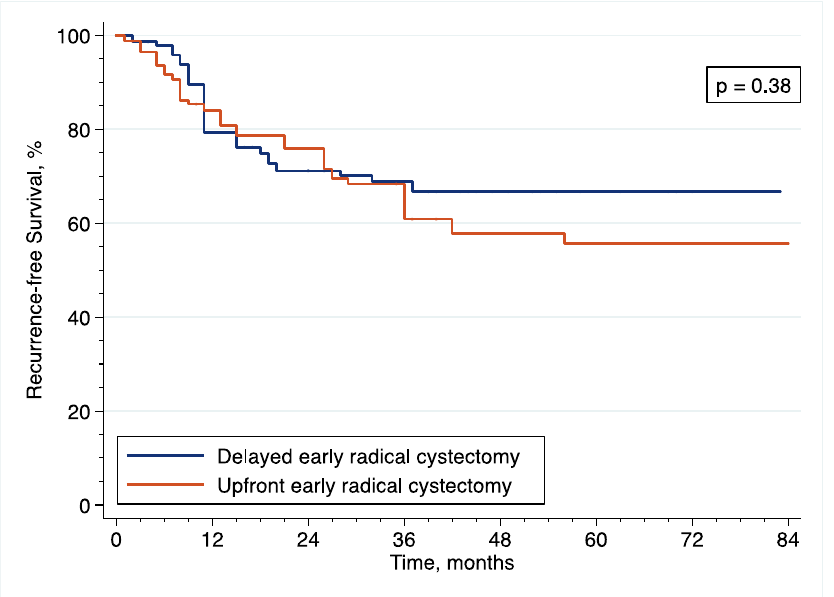
Figure 6. Inverse probability of treatment weighting (IPTW)-adjusted Kaplan–Meier curves that compare the RFS of included patients treated with upfront or delayed eRC for HR-NMIBC.